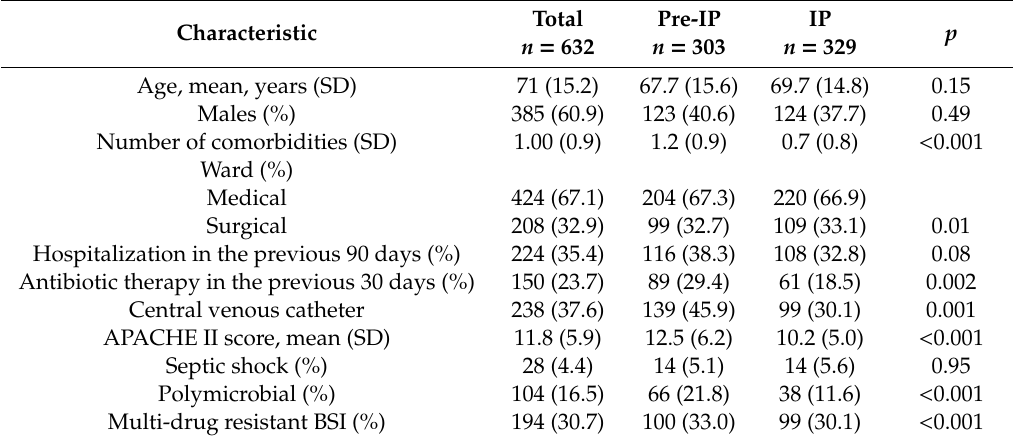
Table 1. Baseline demographic and clinical characteristics of the study cohort.